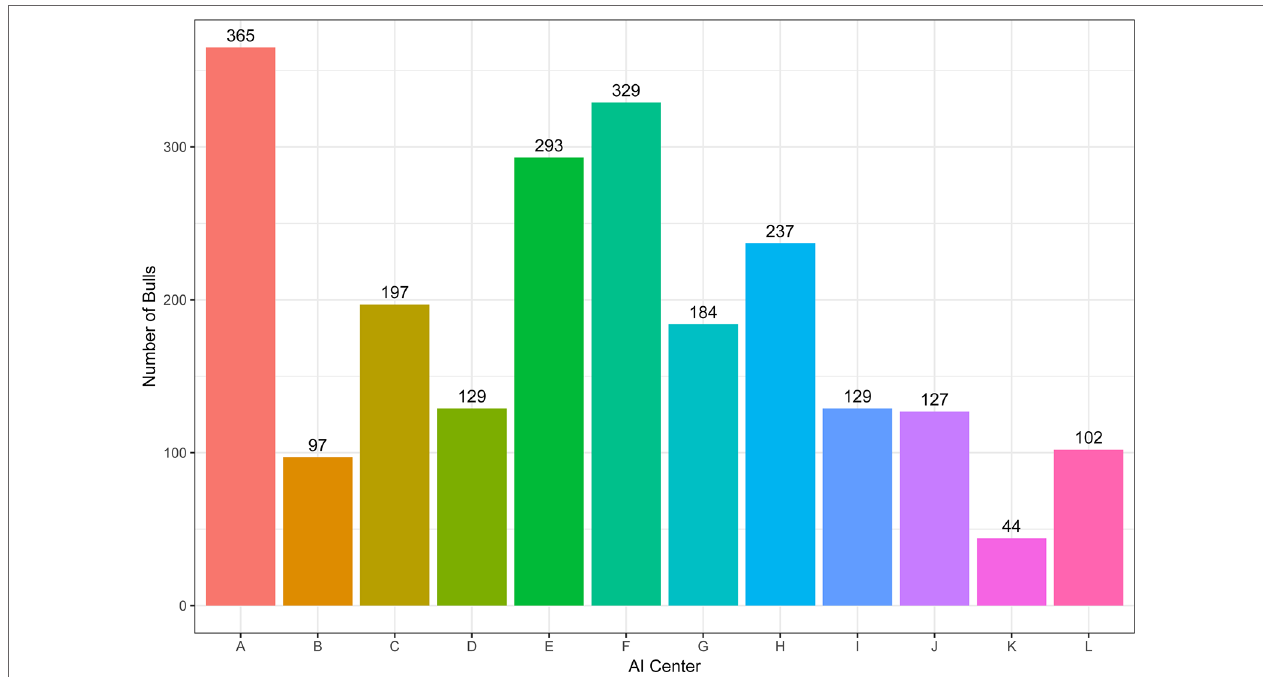
FIGURe 1 | The distribution of bulls across artificial insemination (AI) centers.